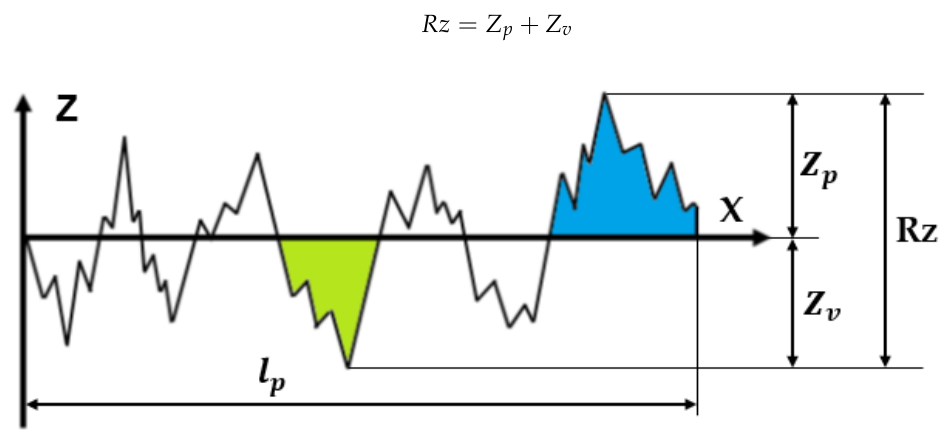
Figure 2. Geometric description of the roughness parameter Rz.